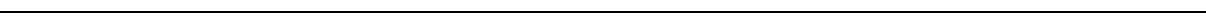
Fig. 5 Inhibiting axonal activity during early development decreases myelination in an axon-selective manner. a Representative images of sagittal sections of the corpus callosum at the midline of P20 mice that had been electroporated with plasmids containing either Kcnj2 and Gfp (Kir2.1) or Gfp only (Control) in utero at E15.5. White arrowheads indicate MBP + /GFP + axons. b , c GFP + axons in the Kir2.1-expressing mice displayed reduced myelination compared to GFP only electroporated controls ( b ), though the density of electroporated axons was comparable in both conditions ( c ). d Representative images showing MBP + /PAN-NF + axons in the corpus callosum. e , f There was no difference in either the percentage of myelinated PAN-NF + axons ( e ) or the density of MBP + rings ( f ) between Kir2.1 mice and controls. g Representative images of the corpus callosum immunolabeled with OPC marker PdgfRa (red) and proliferation marker Ki67 (white). h – j There was no change in the density of proliferating cells ( h ), the total number of OPCs ( i ) or the density of proliferating OPCs ( j ) between Kir2.1 mice and controls. k Representative images of the corpus callosum immunolabeled with oligodendrocyte lineage marker OLIG2 (blue), mature oligodendrocyte marker CC1 (red), and GFP (green). l There was no signi fi cant difference in the density of mature oligodendrocytes between Kir2.1 and control mice. Welch ’ s corrected unpaired two-tailed t -test: *** P < 0.001; n = 10 mice/group ( a – f ), n = 5 mice/group ( g – l ), ± s.e.m. Scale bars = 5 µ m ( a , d ), 200 µ m ( g , k